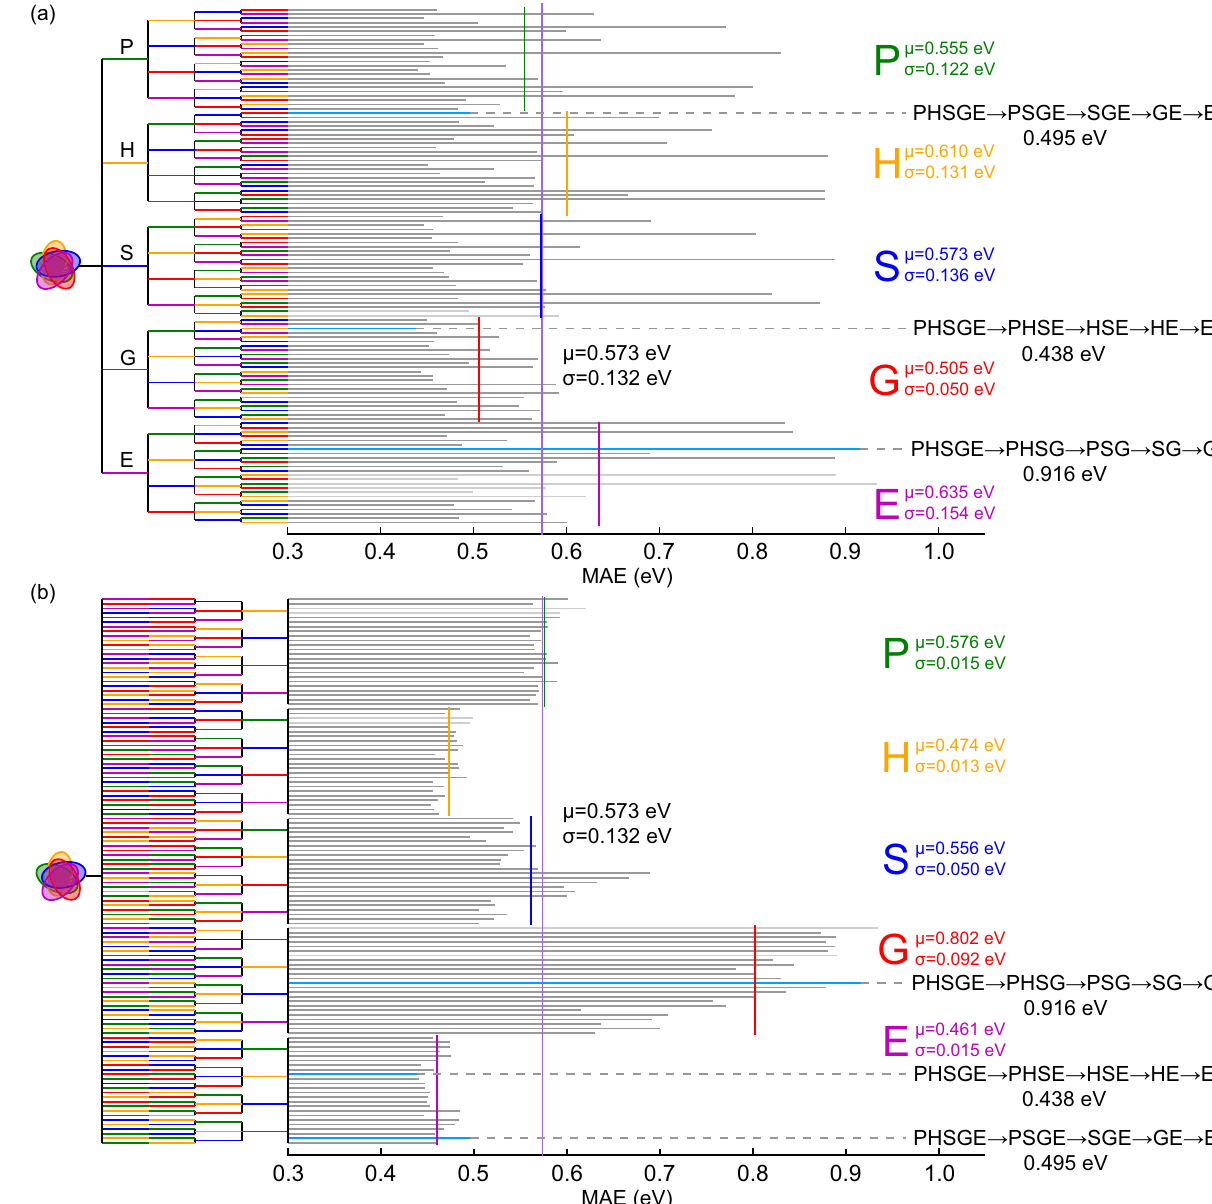
Fig. 6 MAE results on the raw data using the onion training approach. All possible dataset orders are gathered a according to the fi rst dataset used and b following the last dataset used. The global average of the MAE is shown by a vertical solid purple line ( μ = 0.573 eV), while the group averages are indicated by their corresponding color (P in green, H in orange, S in blue, G in red, and E in magenta). The corresponding standard deviations ( σ ) are also indicated accordingly. The best and worst training sequences, as well as the worst one ending by E, are highlighted in light blue. The training sequences that produce NaN for one of the folds (so the MAE is only that of the other fold) are indicated by a lighter gray bar, while those that lead to NaN for both folds are left